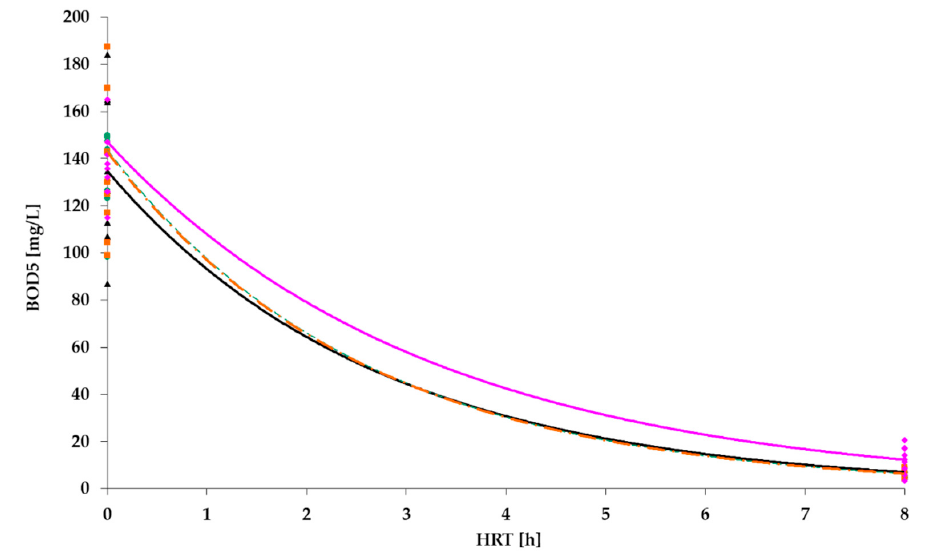
Figure 12. BOD removal dynamics if: floating carrier BB is 10% of reactor volume (black); 20% of tank volume (green); 30% of tank volume (orange); no carrier in the reactor (magenta). Hydrology 2021 , 8 , x FOR PEER REVIEW 11 of 15